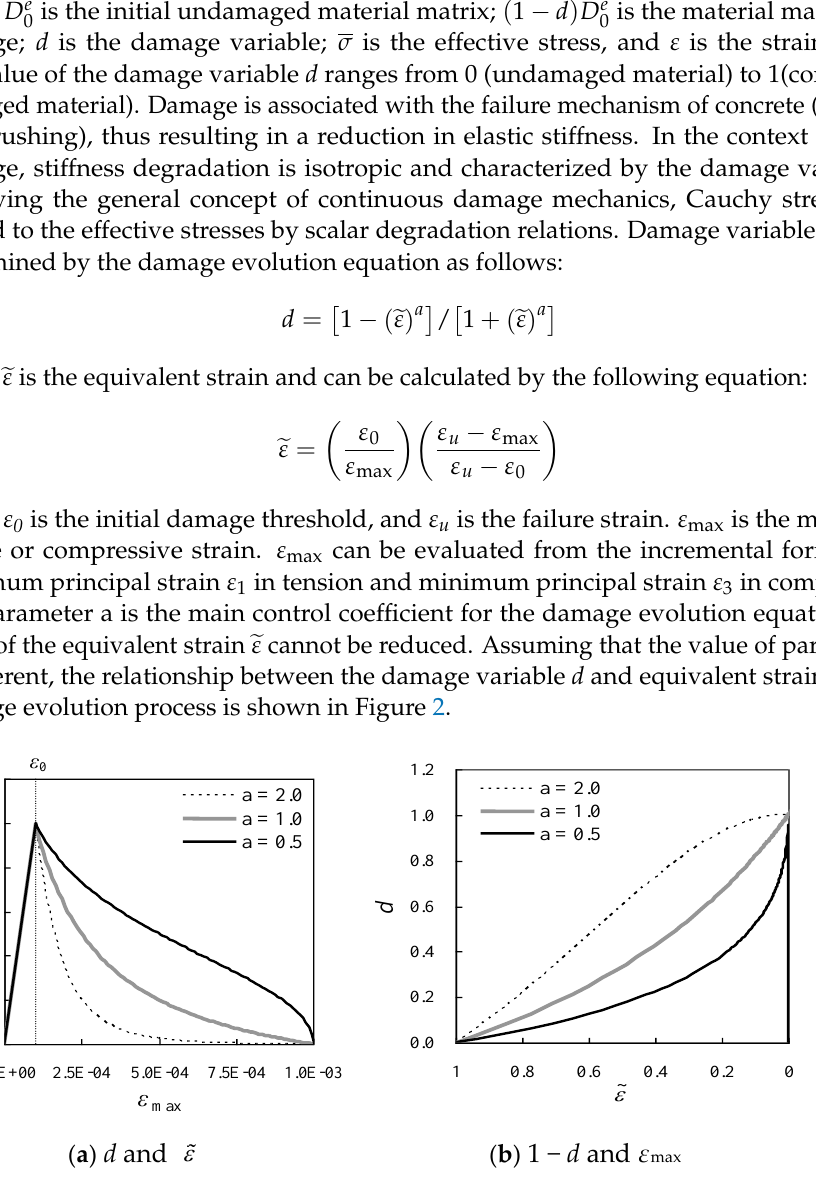
Figure 2. Curves of damage evolution